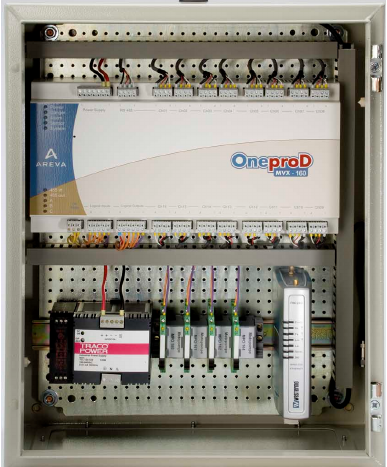
Рис . 2 – Встроенная защитная система мониторинга для мини -